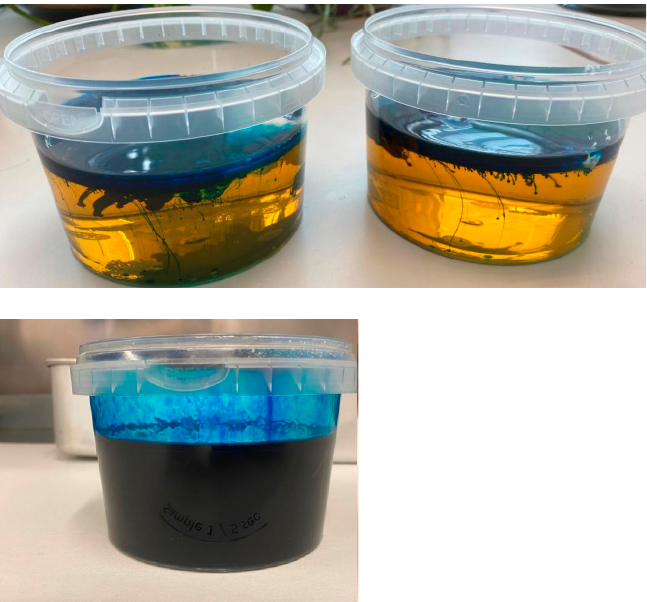
Figure 5. Image of the lab case 7 mixing: ( Above ) Before the mixing process, surfactant is visible in the lowest part of the canister in yellow color, and dye solution, with perfume, in the upper part in dark blue color; and ( Below ) after the mixing process. Table 2. Cases table. Cases are defined by the percentage of each mixture component. Case